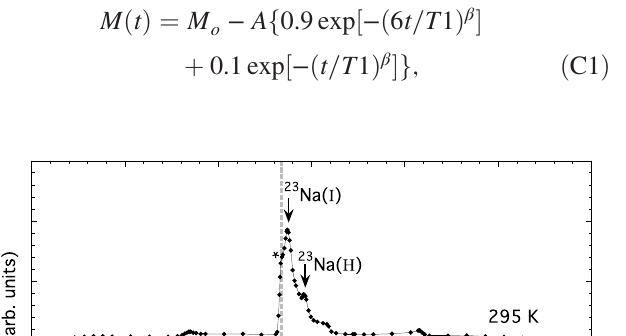
FIG. 18. T 1 recovery curves for the nuclear spin I z ¼ þ 1 = 2 to − 1 = 2 central transition of the interlayer 23 Na ð I Þ sites of Na at select temperatures. Solid and dashed curves represent the fit with Eq. (C1) with the stretched exponent β above and below T N , respectively. The magnitude of β is close to 1 above T N , as shown in the inset.